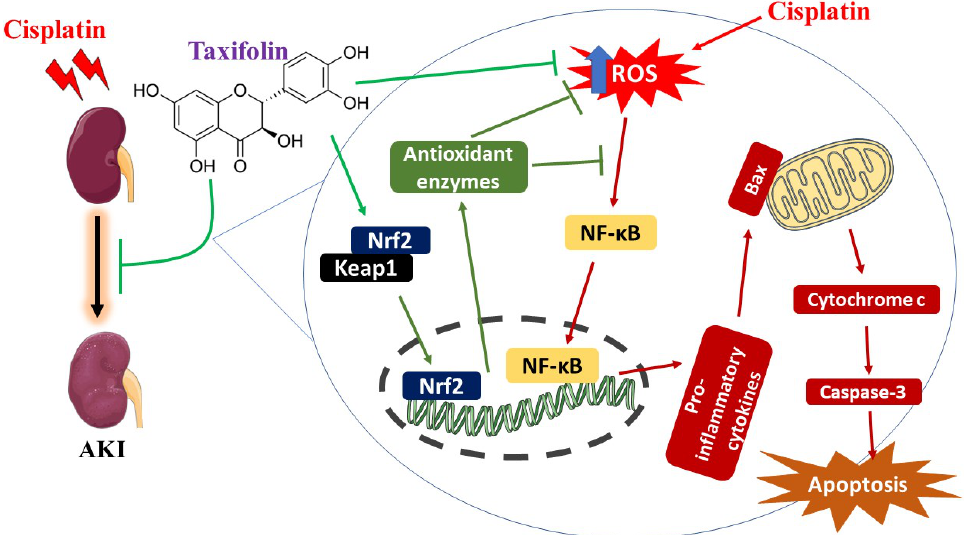
Figure 9. A schematic diagram illustrating the protective effect of taxifolin against cisplatin-induced AKI. Cisplatin induces oxidative stress and activates NF- κB, leading to the release of pro-inflammatory cytokines and apoptosis. Taxifolin mitigated cisplatin-induced acute kidney injury (AKI) by upregulating Nrf2 and preventing oxidative stress, inflammation, and apoptosis.